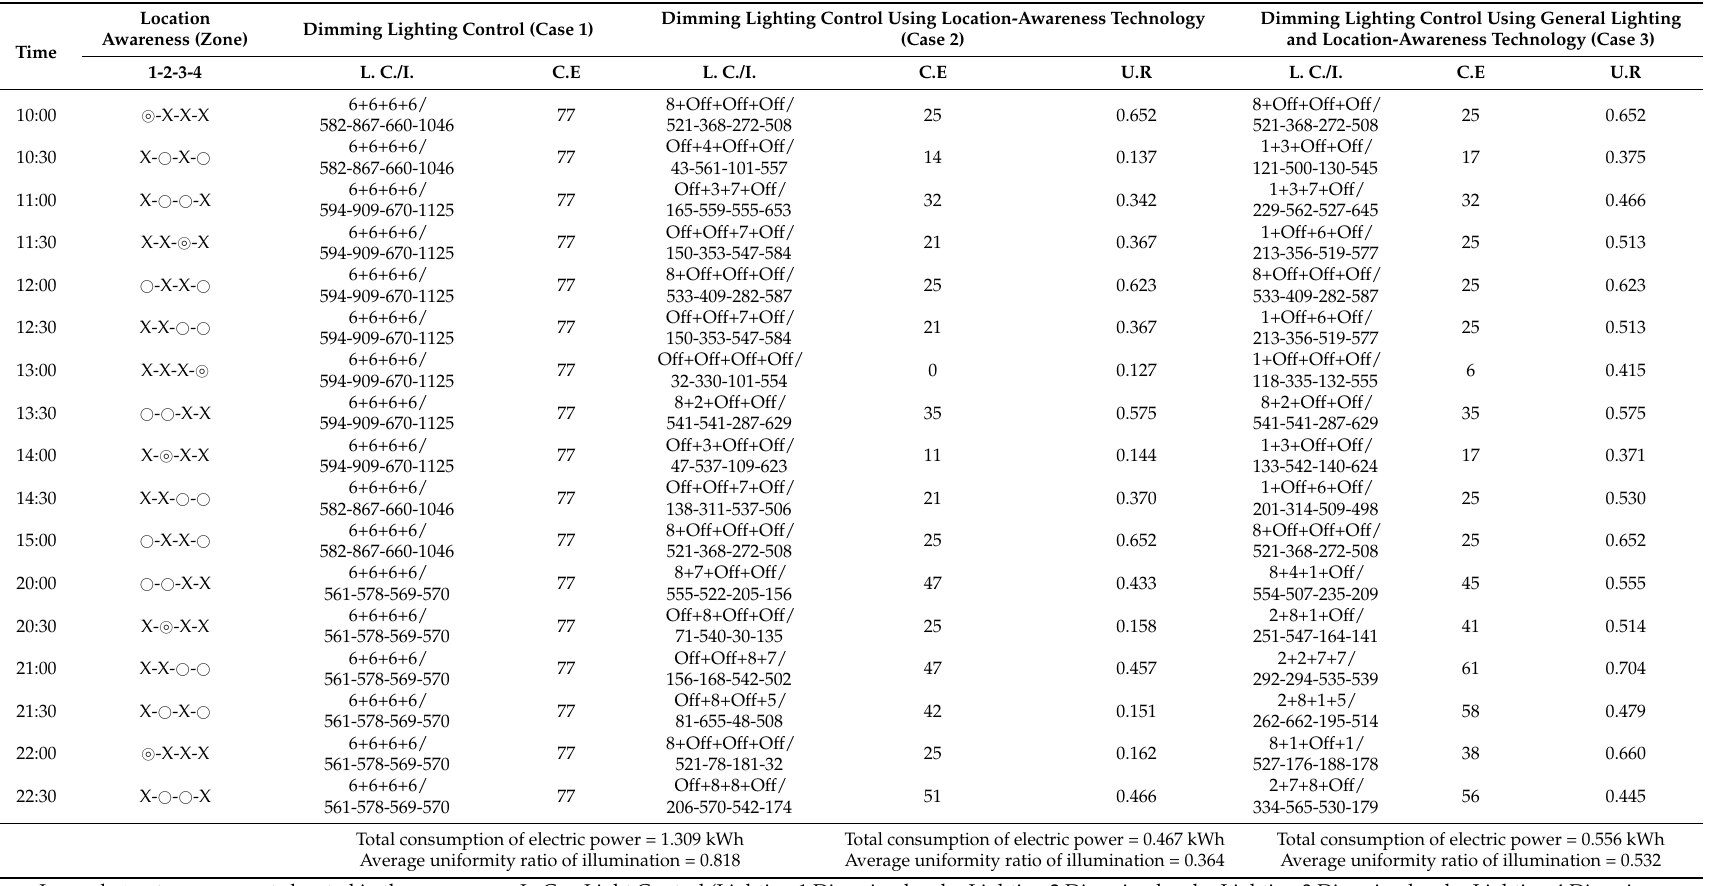
Table 10. Performance evaluation results based on two